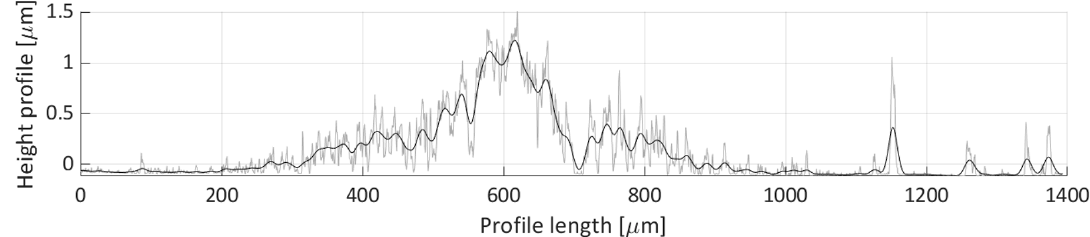
Figure 24. Height profile for the H4 line.